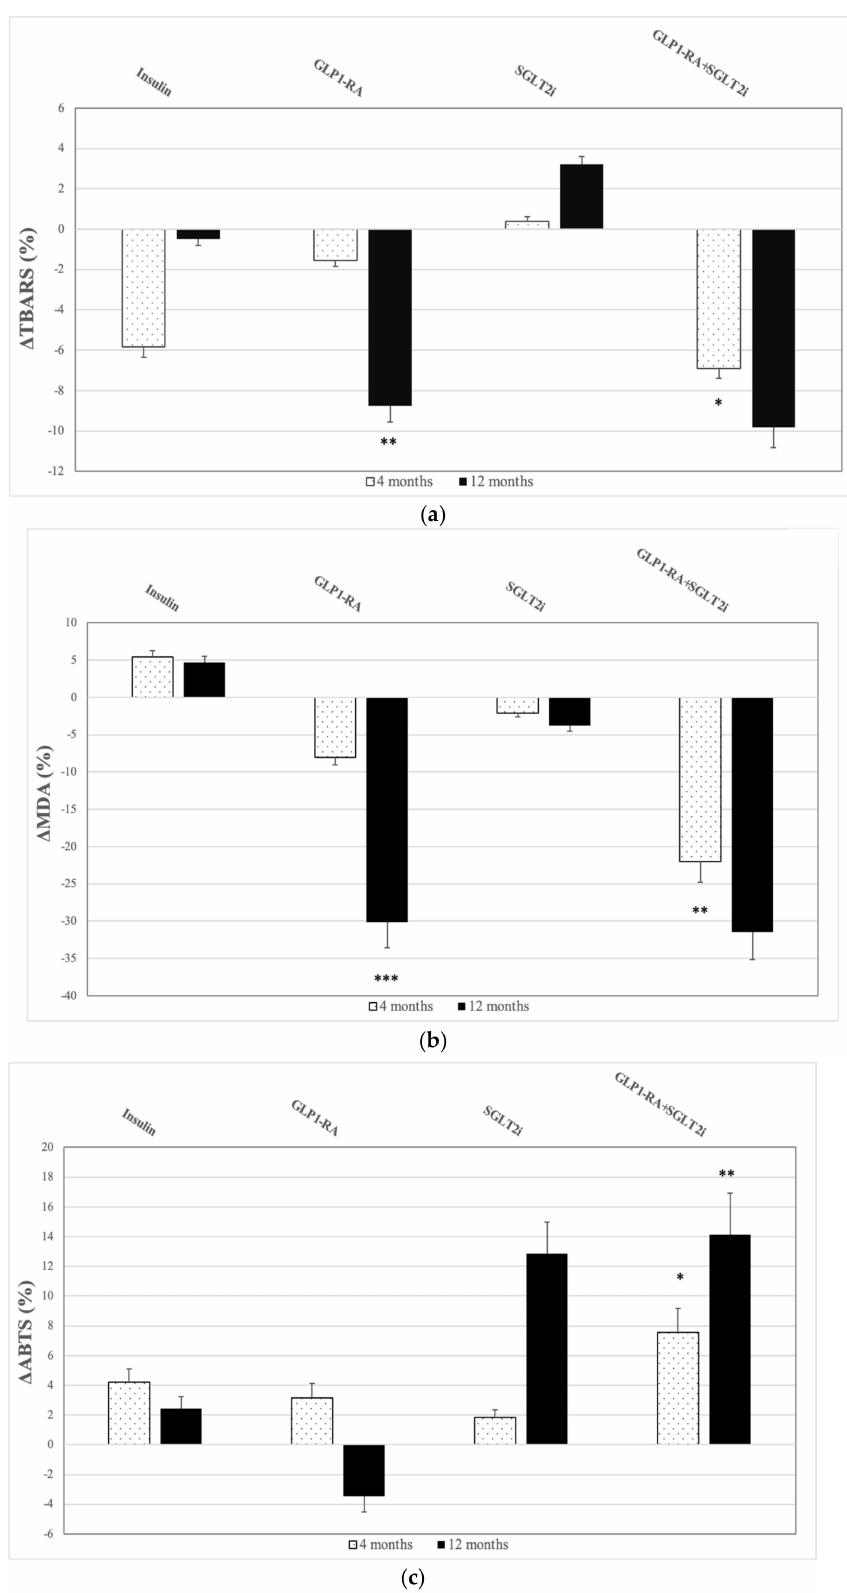
Figure 2. Percentage changes ( ∆ ) from baseline in -( a ) Thiobarbituric Acid Reactive Substances (TBARS), -( b ) Malondialdehyde (MDA) and -( c ) 2,2¢-azino-bis-(3-ethylbenzthiazoline-6-sulphonic acid) radical (ABTS) at 4 and 12 months in the 4 study groups. Data are presented as means ± SD. * p < 0.05; ** p < 0.01; *** p < 0.001 versus